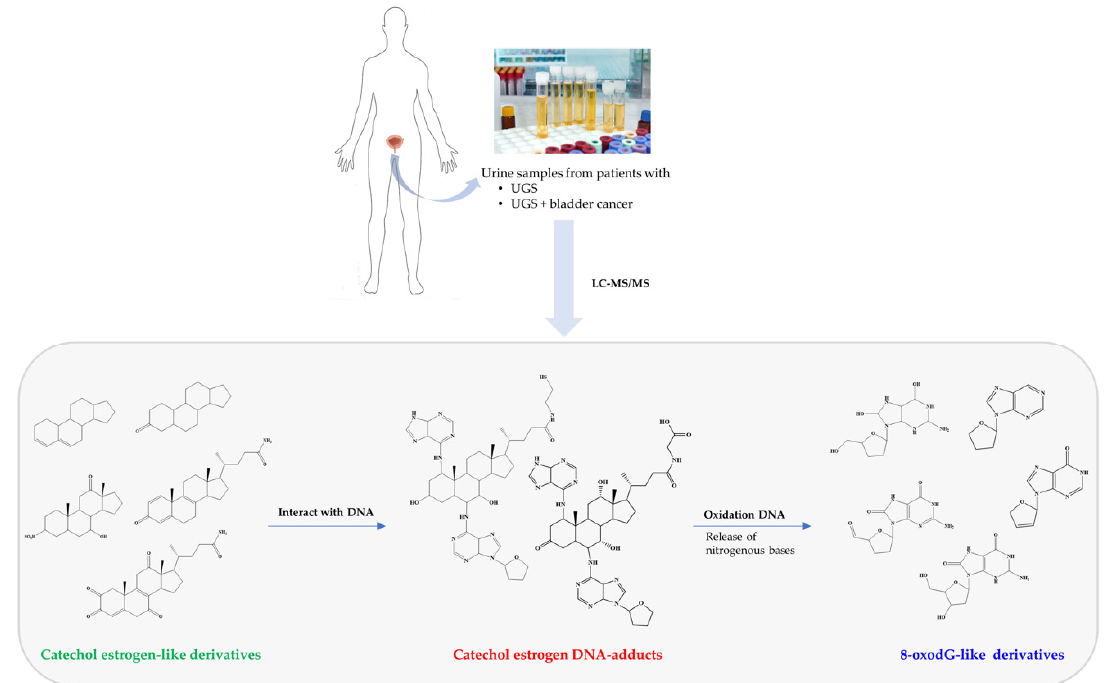
Figure 2. Metabolites identified in urine with UGS and UGS-associated SCC that were not present in urine of healthy individuals [65]. The metabolites were divided in three groups: catechol estrogen-like ( green ), catechol-estrogen-DNA adducts ( red ) and 8-oxodG derivatives ( blue ). The catechol estrogen-DNA adducts may be a consequence of interaction of catechol estrogen derivatives with host DNA. On other hand, 8-oxodG derivatives may be a result of liberation of nitrogenous bases from DNA and/or its oxidation.